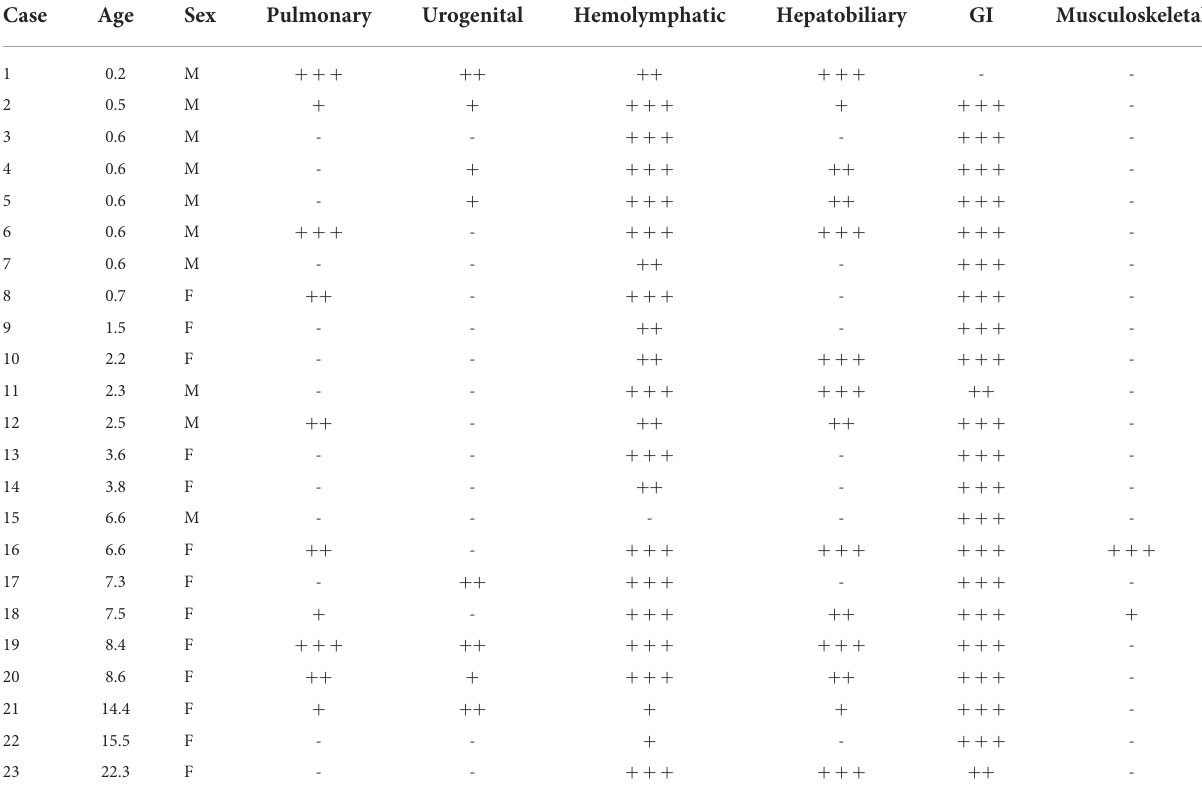
TABLE 2 Summary of histologic lesions by organ system in African green monkeys infected with Yersinia enterocolitica a